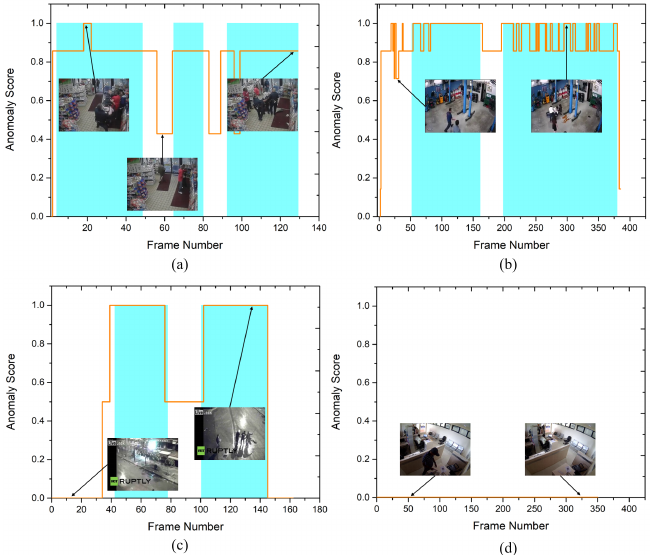
Figure 6. The curves of anomaly score, for four test videos from the test set of the UCF-Crime dataset ( a ) Arrest048-x264, ( b ) Fighting047-x264, ( c ) Assault051-x264, and ( d ) Normal-Videos-027-x264. Cyan regions denote the ground truth abnormal frames. For better representation, we normalized anomaly scores for every video into the range of [0, 1]. This demonstrates that, as anomalies arise, the anomaly scores increase. (For best results, view in color).